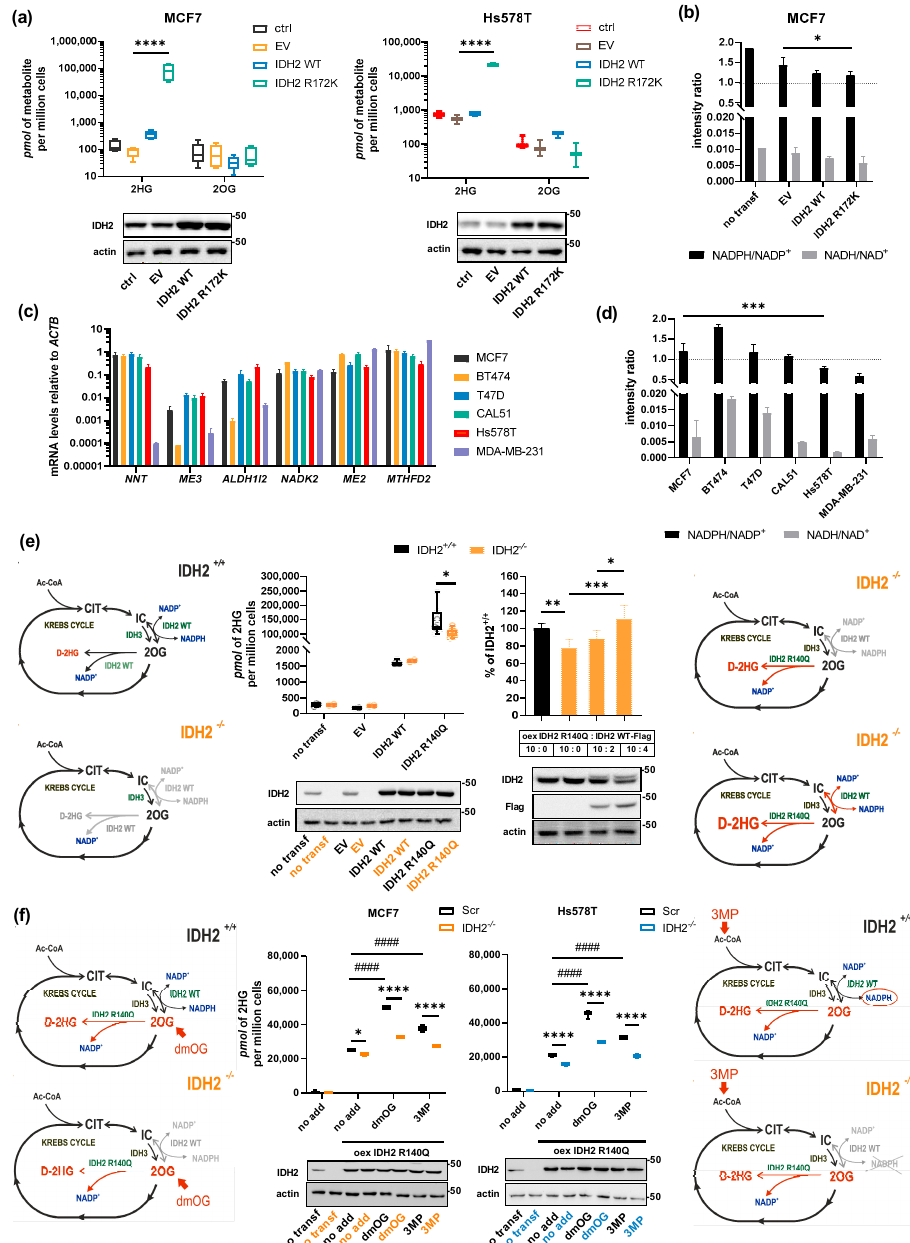
Figure 4. Cofactor balance regulates 2HG production. ( a ) Quantification of the expression level of genes related to mitochondrial NADPH production measured by qPCR or western blot. ( b ) The ratio of cofactors measured from whole-cell lysates in six breast cancer cell lines. n = 3. Two-way ANOVA. ( c ) 2HG and 2OG levels in MCF7 and Hs578T cells transfected with IDH2 WT and IDH2 R172K. n = 6 (MCF7), n = 3 (Hs578T). Two-way ANOVA. ( d ) The ratio of cofactors measured from whole-cell lysates in MCF7 cells transfected with IDH2 WT and IDH2 R172K. n = 3. Two-way ANOVA. ( e ) Middle-left, rescue effect of IDH2 R140Q in IDH2 +/+ and IDH2 − / − cells, corresponding 2HG production. n > 3. Two-way ANOVA. Middle-right, expression of IDH2 R140Q and WT-Flag variant in 10:0, 10:2, and 10:4 ratios ( µ g: µ g), respectively. n = 6. One-way ANOVA. Western blots depict IDH2 expression and IDH2-Flag expression (WT). Schemes depict the experimental design. ( f ) 2HG levels representing rescue effects provided by dmOG and 3MP treatment in Scr and IDH2 − / − cells expressing IDH2 R140Q. n = 3. Two-way ANOVA. Western blots depict IDH2 and actin expression; the order of lanes is identical to the boxes in the graphs above. Schemes depict respective experimental design. * p < 0.05 ** p < 0.01 *** p < 0.001 **** p < 0.0001, #### p <